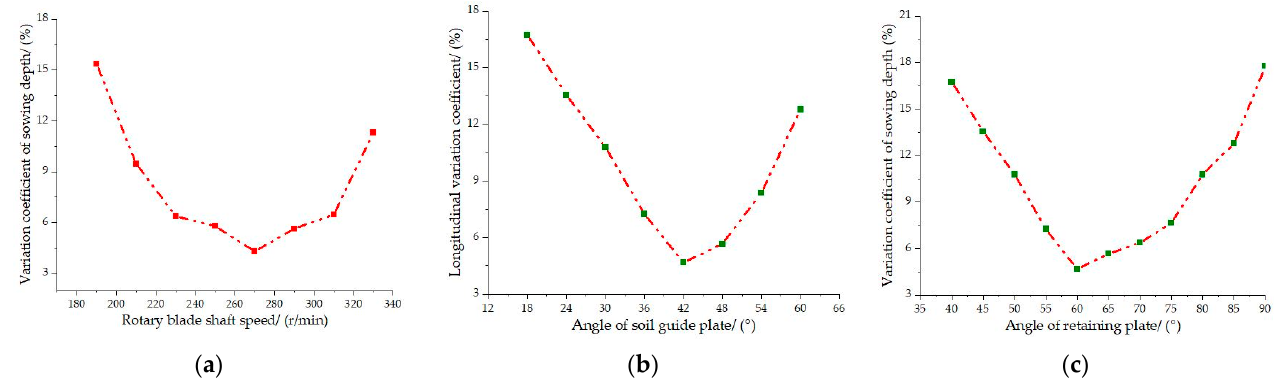
Figure 10. Single factor test results of the variation coefficient of sowing depth: ( a ) the relationship between the rotation speed of the rotary blade shaft and the variation coefficient of sowing depth; ( b ) the relationship between the angle of soil guide plate and the variation coefficient of sowing depth; ( c ) the relationship between the angle of the soil-retaining plate and the variation coefficient of the sowing depth.